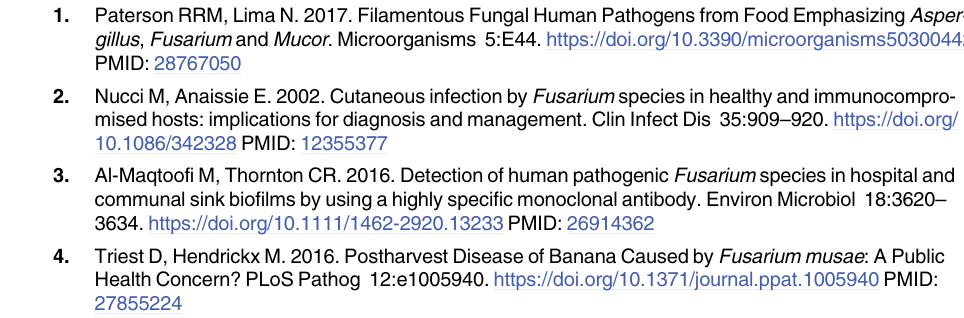
indicate the nucleotide bases that differ between the HOFo, nonpathogenic and pathogenic Fo isolates. The dashes indicate base gaps. The dashed line region represented the sequence of specific primers, Primer5 (A) and ST33-R (B). (TIF) S2 Fig. The Fusarium wilt symptoms on tomato. The 7-10-day-old cherry tomato seedlings (‘Yu-Nyu’, Known-You Seed Co. Ltd) were used hypocotyl cutting inoculation method to inoculate with F. oxysporum f. sp. lycopersici (isolate of Fol146) (5x10 4 /ml conidial suspen- sions) for 30 min. The diseased plants usually showed cotyledon and first leaf with yellowing, stunting, and wilting symptoms. (TIF) S1 Raw